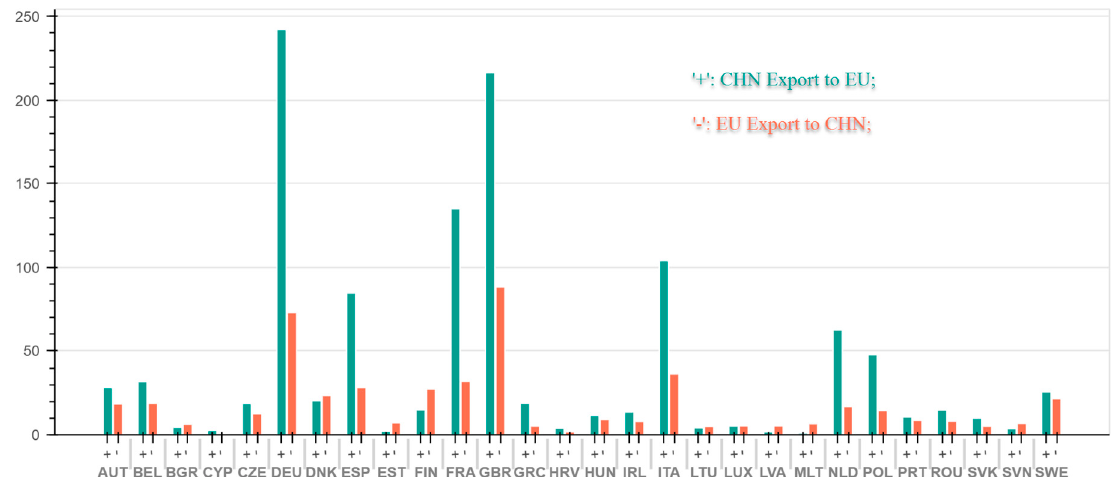
Figure 6. Embodied NOx flows in bilateral trade between China and 28 EU countries in 2014. (The x-axis represents EU countries, and the y-axis represents NO X emissions)(Unit: kiloton).